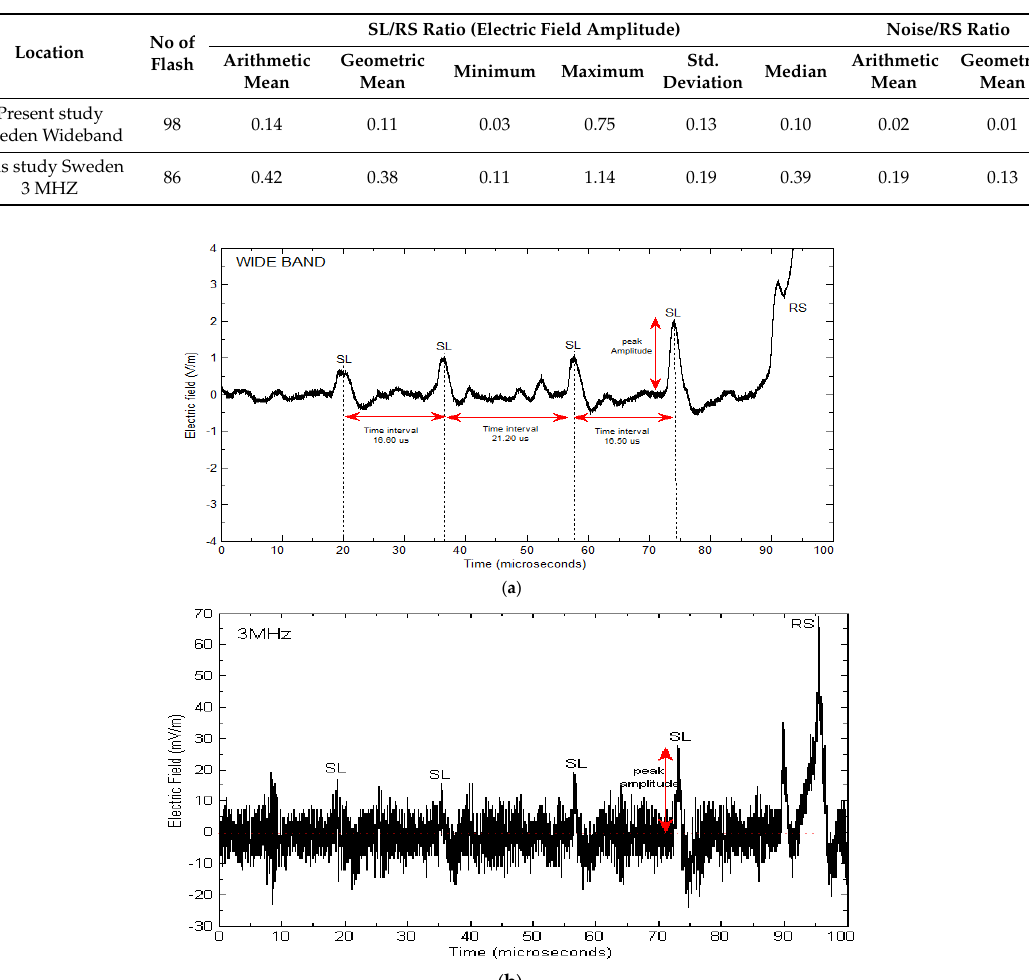
Figure 4. A section of the flash in which stepped leaders at ( a ) wideband and ( b ) 3 MHz are shown. Recorded on 19/07/2014 at 18:25:47:489,798 from a flash located (60.18510°N, 17.87690°E) at a distance of 40.76 km from the measuring station T = 0 was 7.6630 ms from the trigger time.